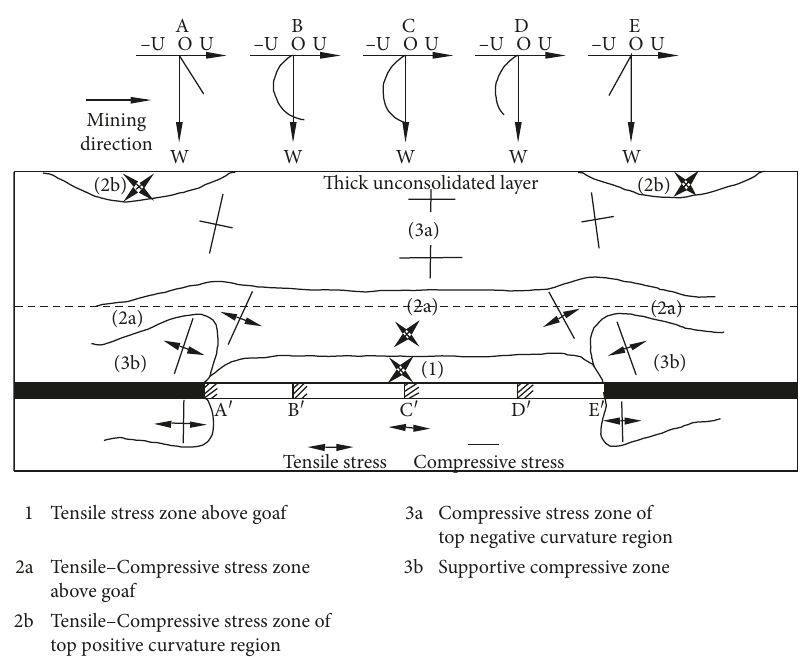
Figure 10: Dynamic trajectories of the surface points and the corresponding principal stress distribution in overburden disturbed by